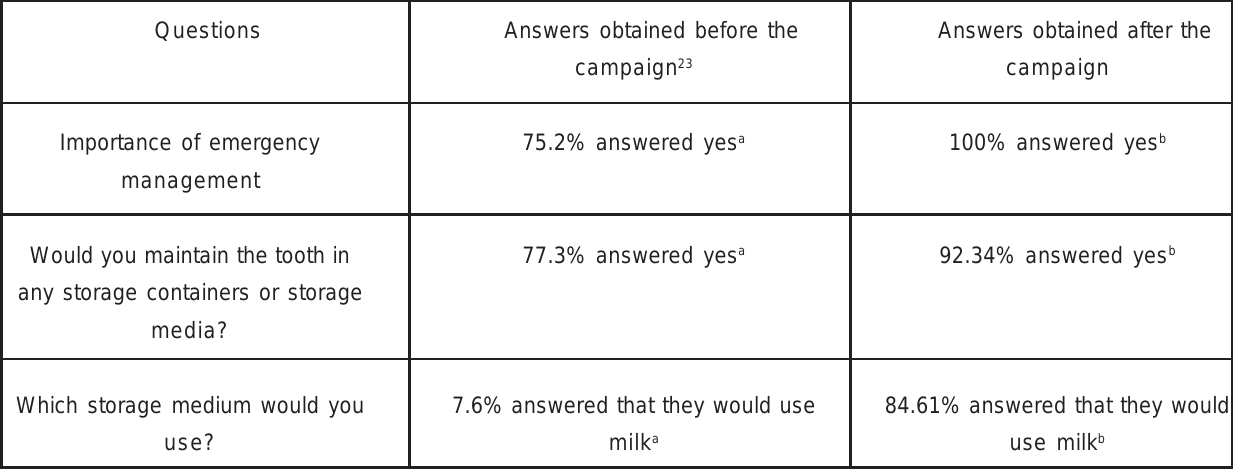
FIGURE 5- Comparison of data obtained before and after the informative campaign on tooth